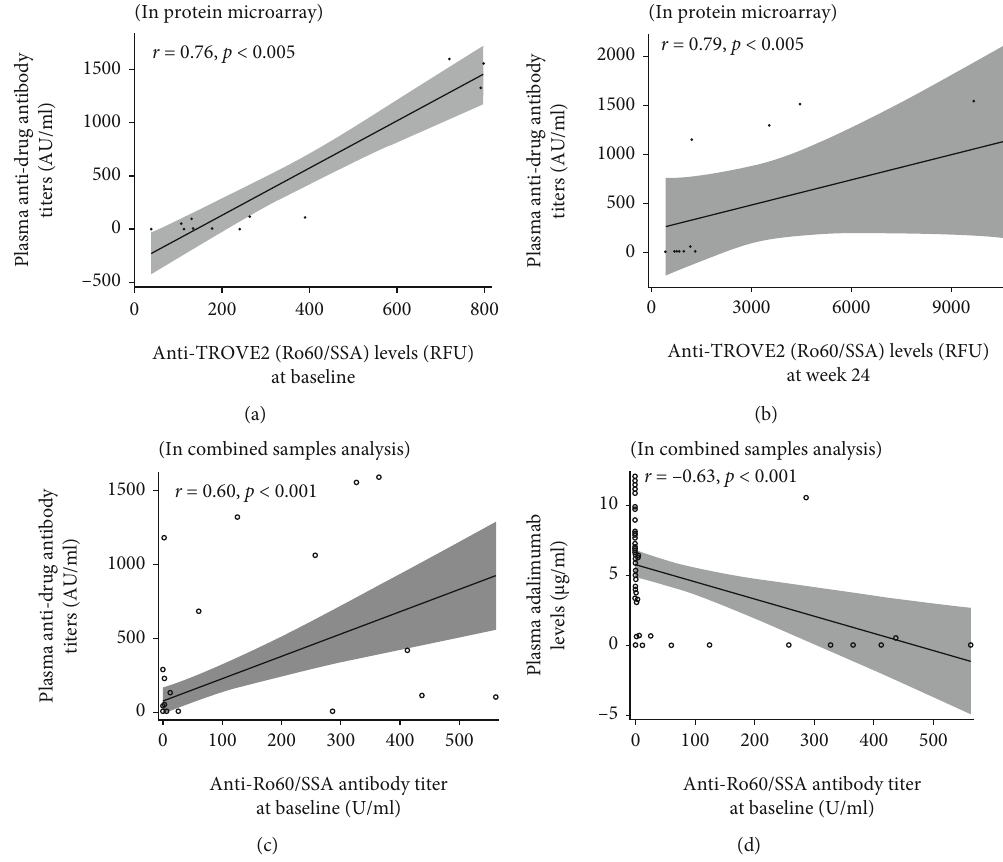
Figure 5: The correlation between anti-TROVE2 (Ro60/SSA) antibody titers either at baseline (a) or at week 24 (b) and plasma anti-drug antibody (ADAb) titers in the protein microarray. The correlation between anti-Ro60/SSA antibody titers at baseline and plasma anti- drug antibody (ADAb) titers (c) or plasma drug levels in combined samples analysis (d). Correlation coe ffi cient ( R ) was calculated by the Spearman rank correlation